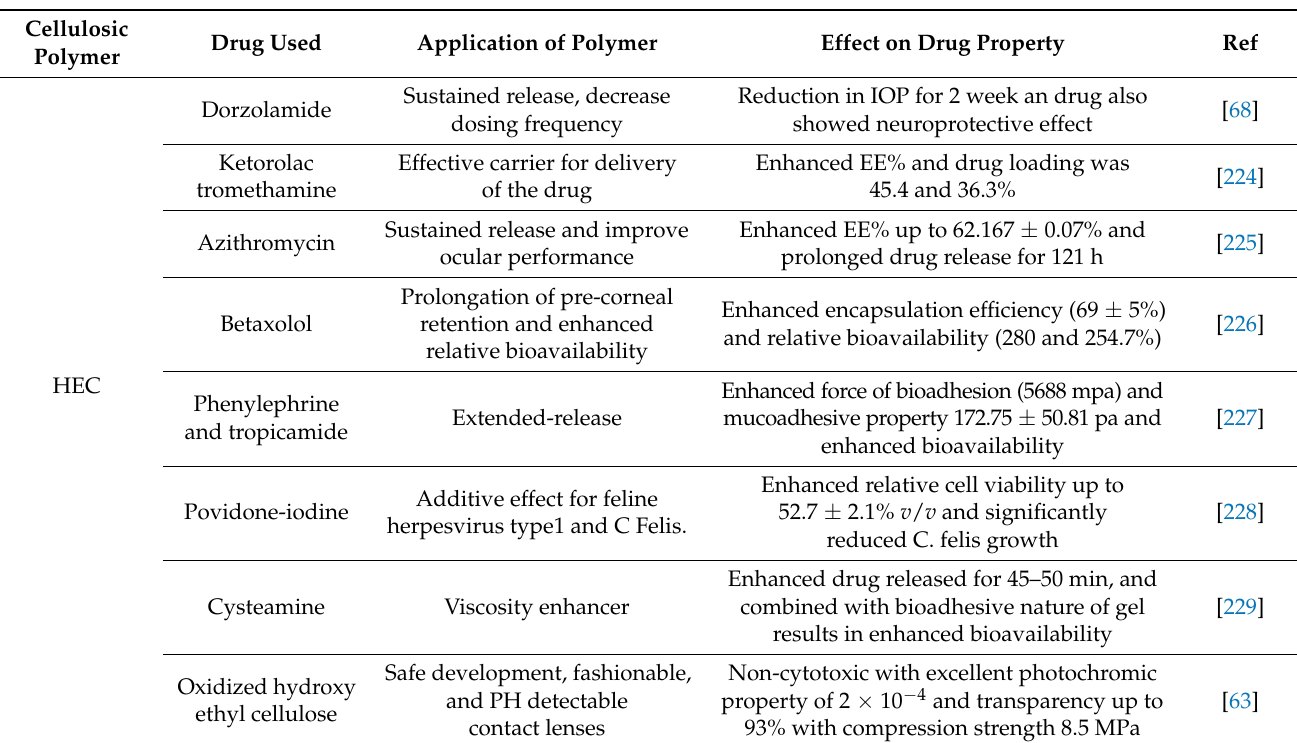
Table 10. Application of HEC in ocular drug